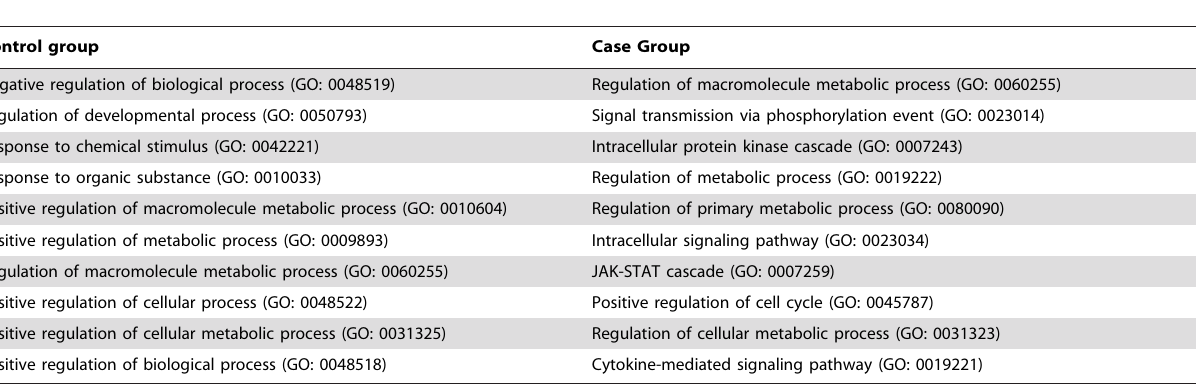
Table 3. Significantly enriched GO biological processes with respect to the integrated deregulated module.